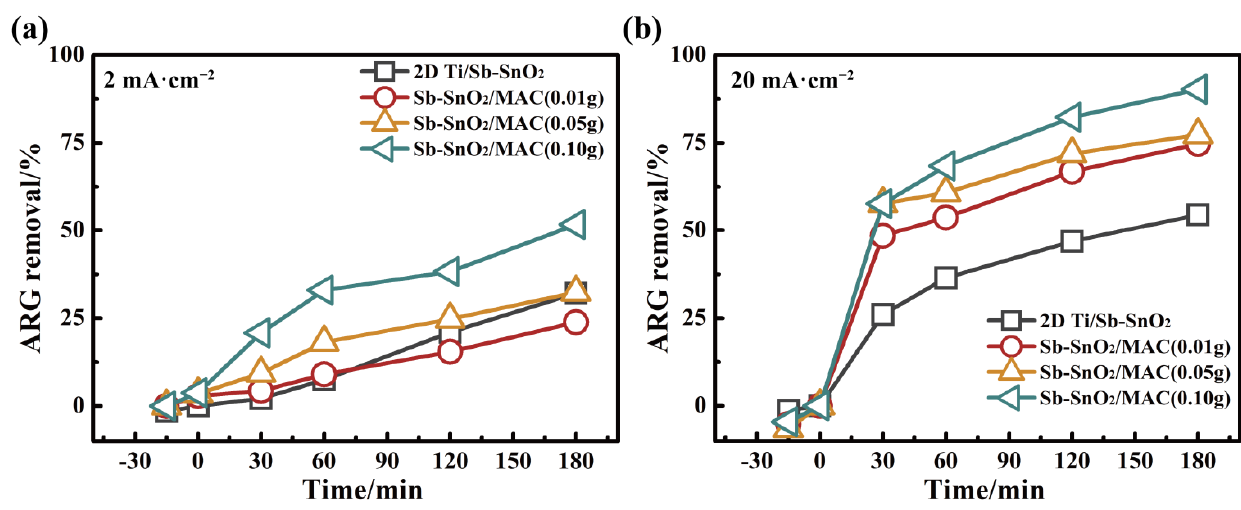
Figure 4. Degradation results of ARG (initial ARG concentration of 200 ppm, anode area of 9 cm 2 , solution volume of 250 mL, 125 ppm of Na 2 SO 4 as supporting electrolyte, room temperature): ( a ) ARG removal percentage versus time under low current density (2 mA·cm −2 ); ( b ) ARG removal percentage versus time under high current density (20 mA·cm −2 ).